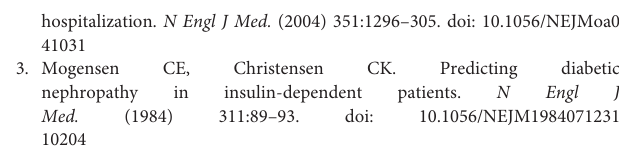
Supplementary Figure S1 | A overview 675 metabolite heatmap between three groups, ie. healthy controls (HC), diabetic controls (DC), diabetic kidney disease patients (DKD). Each line of this graphic represents a relation of different metabolites, colored by their relative intensities (red, upregulated; blue, downregulated). Columns: serum sample groups; rows: metabolites. Each point represents the average metabolite peak counts in each group. Supplementary Figures S2, S3 | Asn-Met-Cys-Ser and Asn-Cys-Pro-Pro were independent of age, sex, SBP, DBP (mmHg), HbA1c (%), TC (mmol/L), TG (mmol/L), eGFR (ml/min/1.73 m 2 ), sCr ( µ mol/L), BUN (mmol/L), Ucr (mmol/L). Supplementary Table S1 | Declustering potential, collision energy, and retention time of two peptides. Supplementary Table S2 | Different metabolites in each